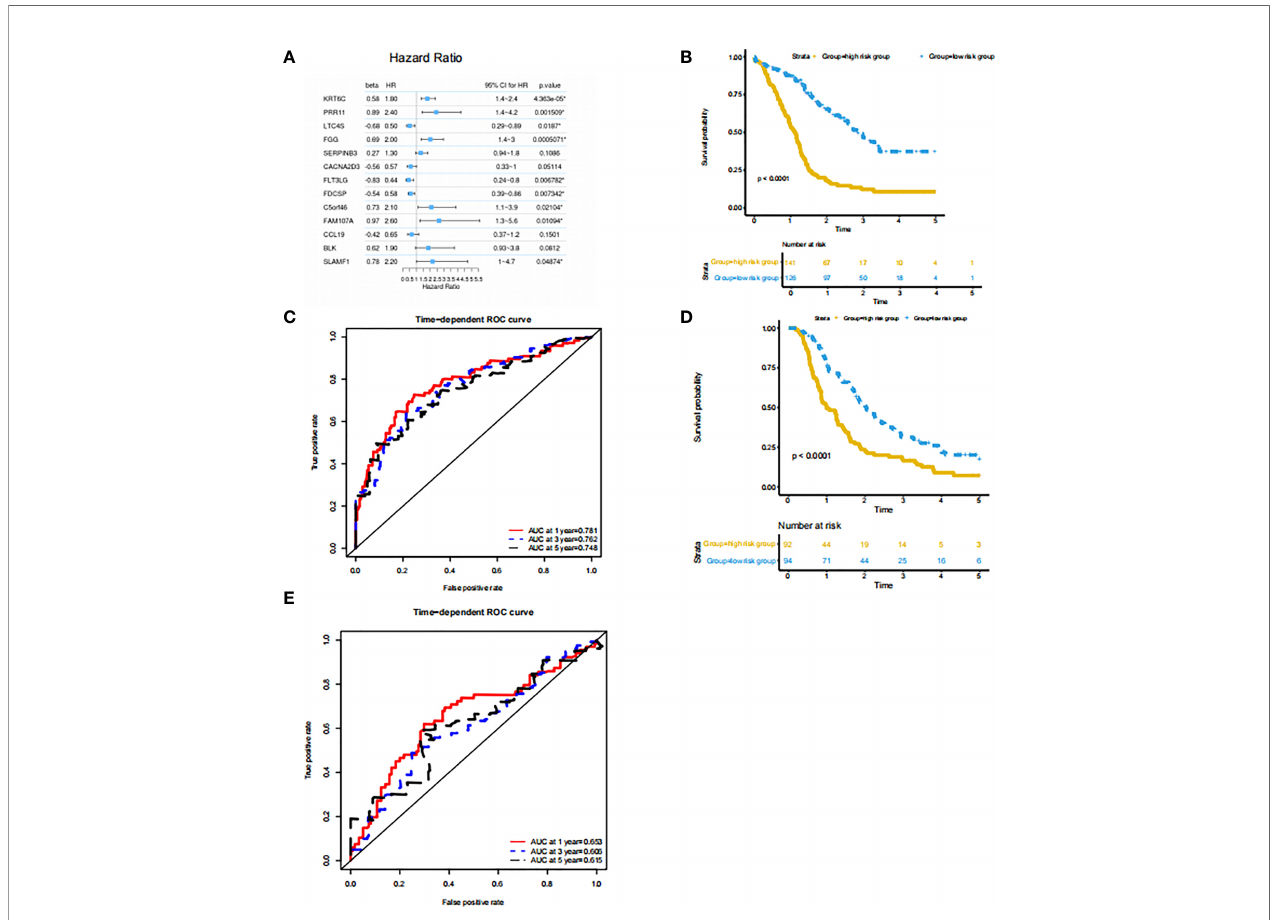
FIGURE 4 | Prognostic prediction model based on signatures of tumor microenvironment (A) features: signi fi cant factor name; multi_beta: Cox multiple regression coef fi cient; multi_HR: Cox multiple regression risk ratio; multi 95% CI for HR: Cox multiple regression risk ratio 95% con fi dence interval; Forest diagram: horizontal line shows the con fi dence interval interval, and the dot represents the hazard ratio; multi_p.value: Cox multiple regression proportional hazard hypothesis test P value. (B) Survival curve of the high and low risk groups in the training set. The horizontal axis represents time (unit: day), the vertical axis represents survival rate. A fl at curve represents a high survival rate or a longer survival period, and a steep curve represents a low survival rate or a shorter survival period. (C) ROC curve of the training set prediction model. The horizontal axis is the false positive rate FP, and the vertical axis is the true positive rate TP. The legend in the upper left corner corresponds to the AUC value of the ROC curve for different survival periods. (D) Survival curves of the high- and low-risk groups in the PACA-CA testing set. (E) ROC curve of PACA-CA test set prediction model. The horizontal axis is the false positive rate (FP), and the vertical axis is the true positive rate (TP). The legend in the upper left corner corresponds to the AUC value of the ROC curve for different survival